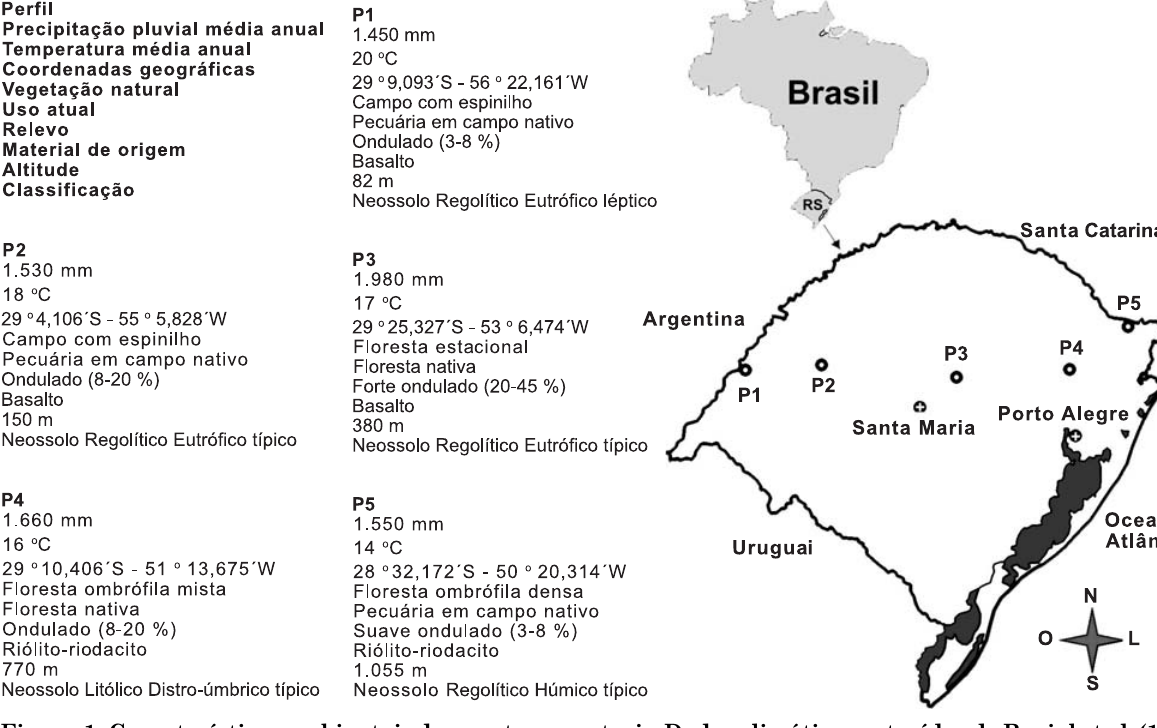
Figura 1. Características ambientais dos pontos amostrais. Dados climáticos extraídos de Buriol et al. (1979) e IPAGRO (1989); dados de vegetação natural extraídos de IBGE (1986) e classificação conforme Embrapa